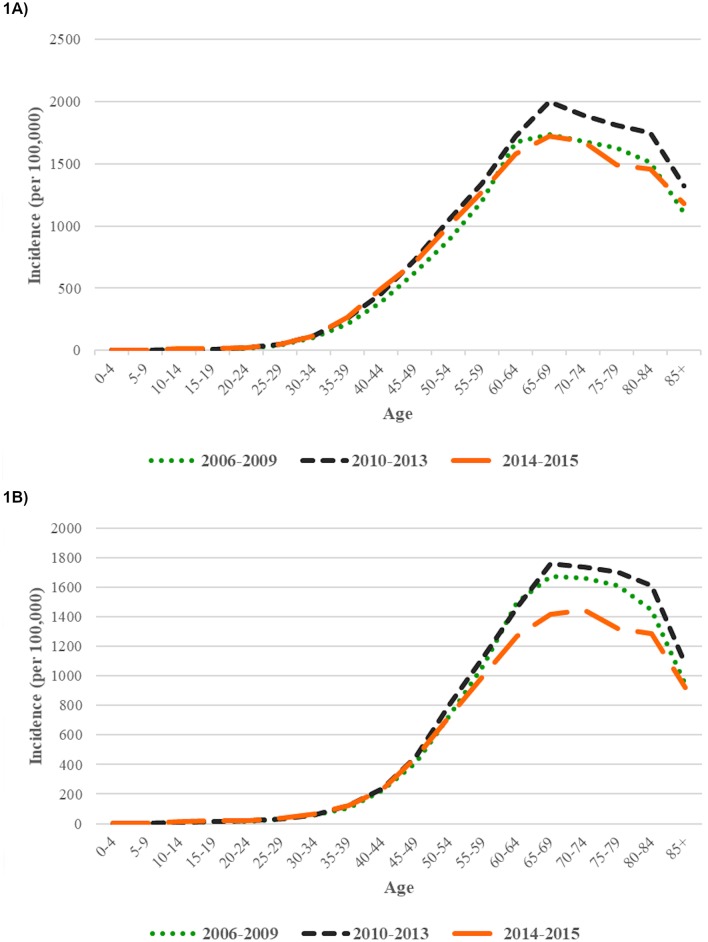
Incidence of type 2 diabetes in Hong Kong Chinese men (A) and women (B) by age stratified by the following calendar periods: 2006–2009, 2010–2013, and 2014–2015.